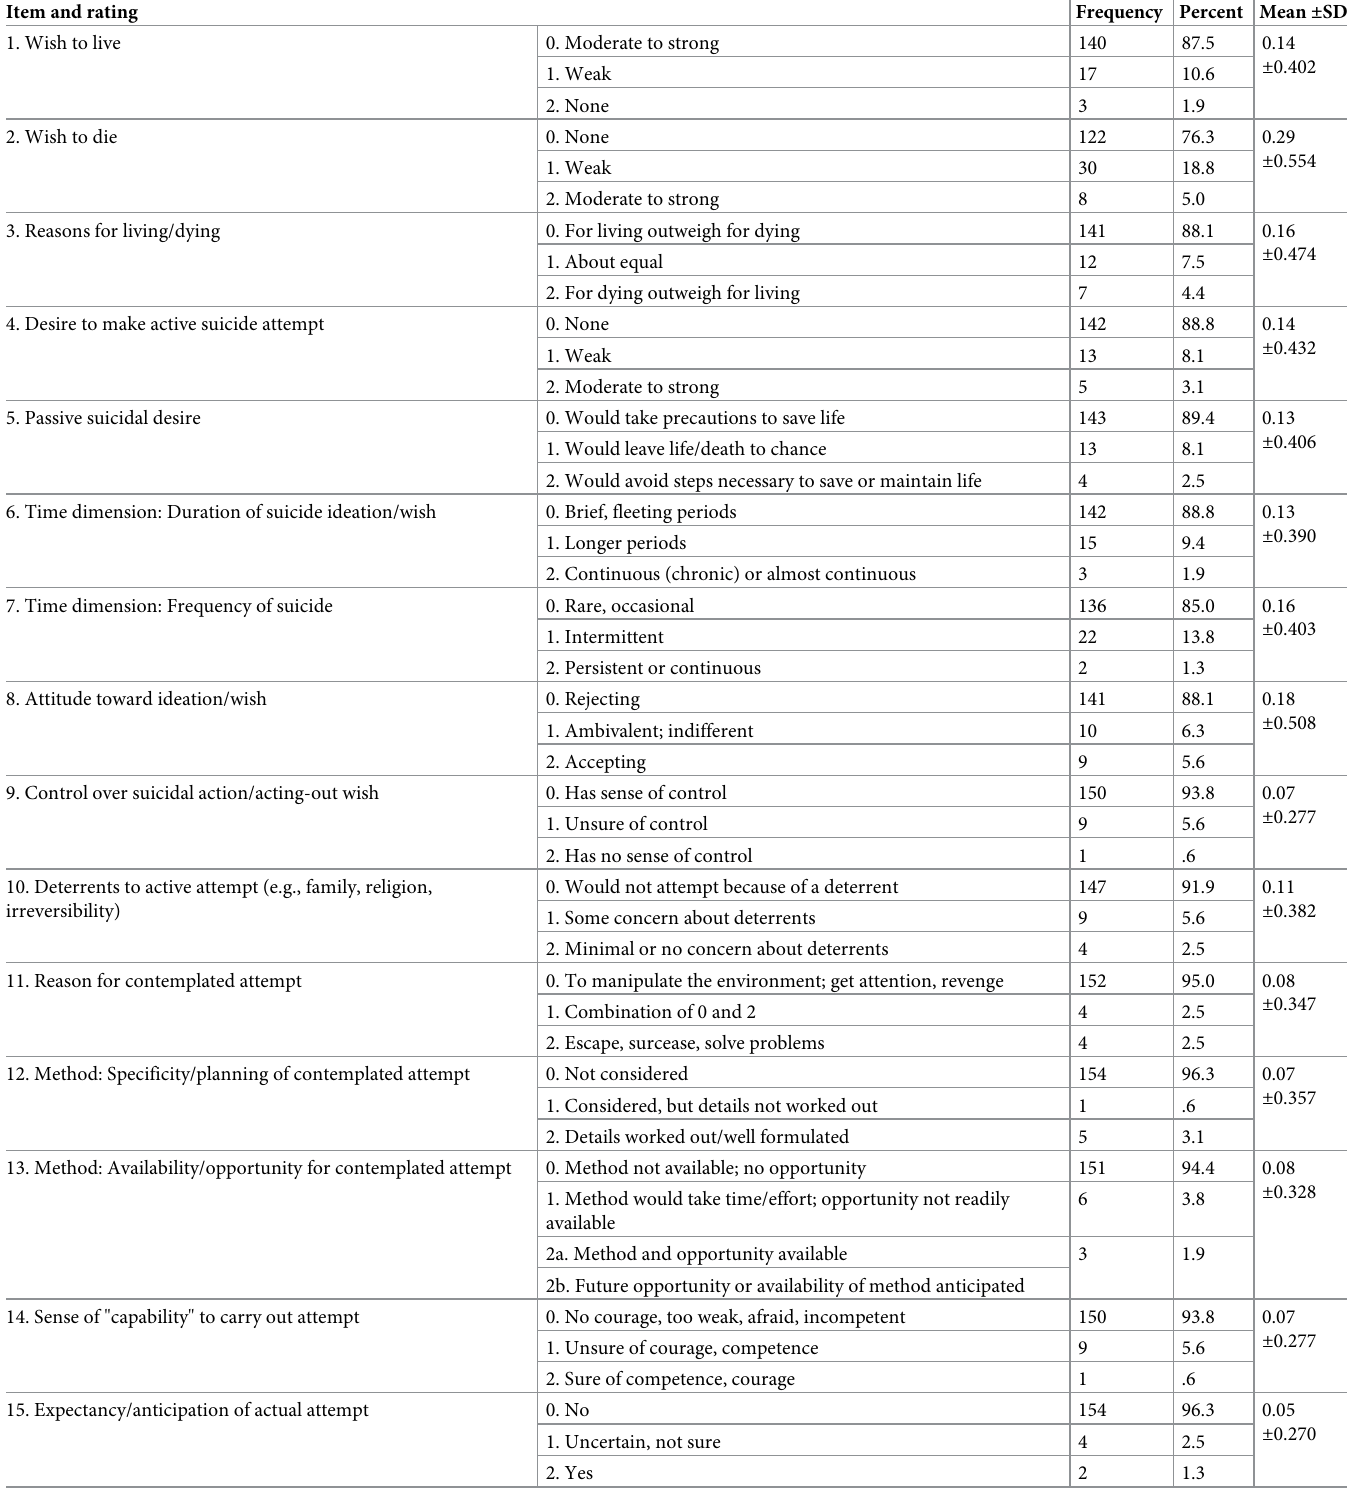
Table 2. Beck scale items and